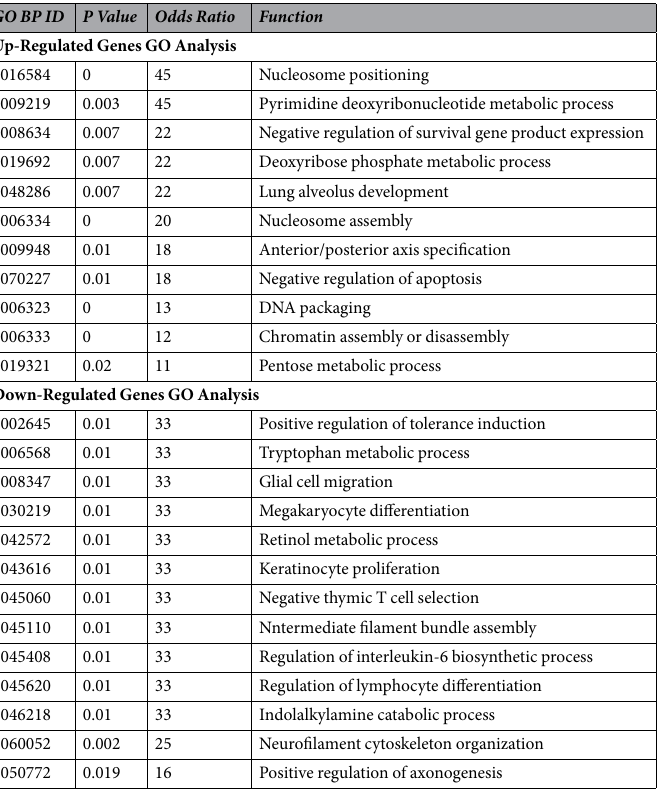
Table 1. GO Analysis of the differentially expressed genes in the H9 cells transduced with mitochondria- targeting constitutively active